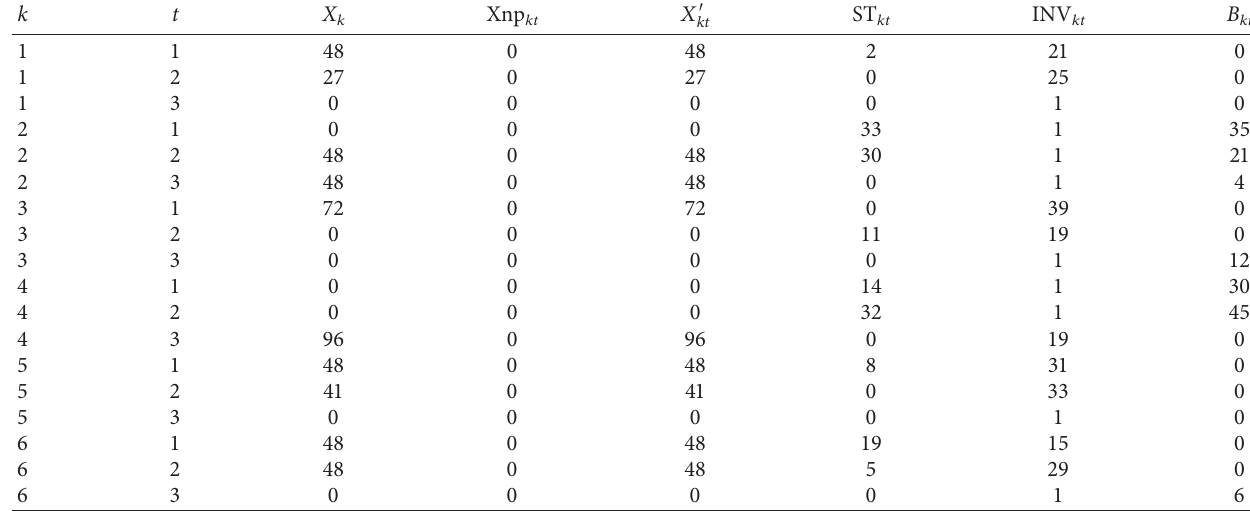
Table 8: Small dataset results of the extended LSSP MILP, with setup common operators: lot sizing, inventories, coverage, stockout, and